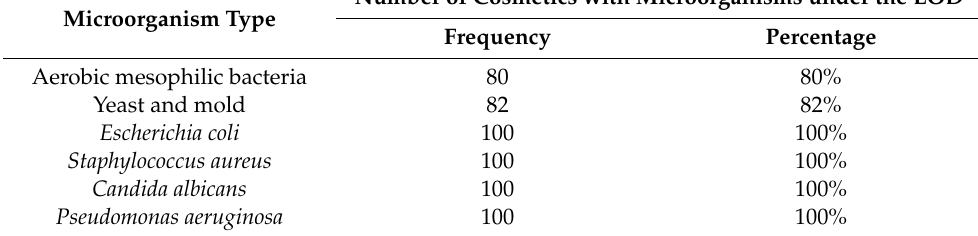
Table 2. Distribution of cosmetic products that contained the tested microorganisms below the limit of detection ( n = 100).